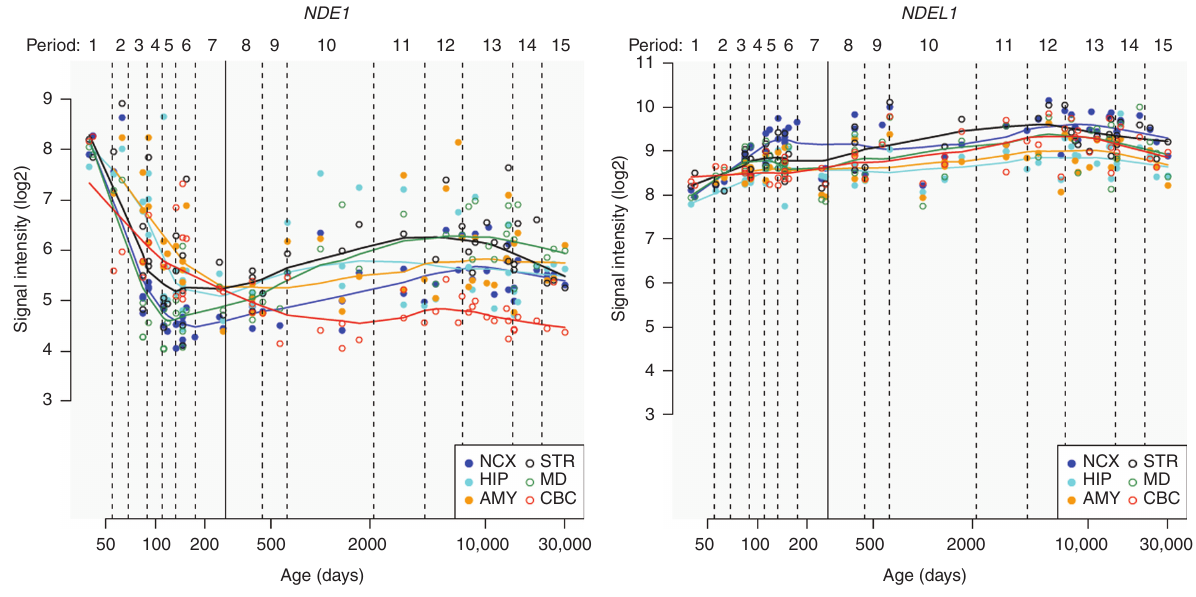
Figure 2 Differential expression of NDE1 and NDEL1 transcripts in the human brain across the lifetime. Change in NDE1 mRNA expression with time is shown in the left panel and NDEL1 in the right panel; developmental age shown on the x-axis in days; mRNA expression signal intensity (Log2) shown on the y-axis. While, expression of NDEL1 across the brain remains relatively steady, NDE1 shows a far more specialized pattern of expression. Abbreviations for brain regions used in figure: NCX, neocortex; STR, stria- tum; HIP, hippocampus; MD, mediodorsal nucleus of the thalamus; AMY, amygdala; CBC, cerebellar cortex. Data and figure accessed from the Human Brain Transcriptome project (http://hbatlas.org/pages/hbtd; used with permission)